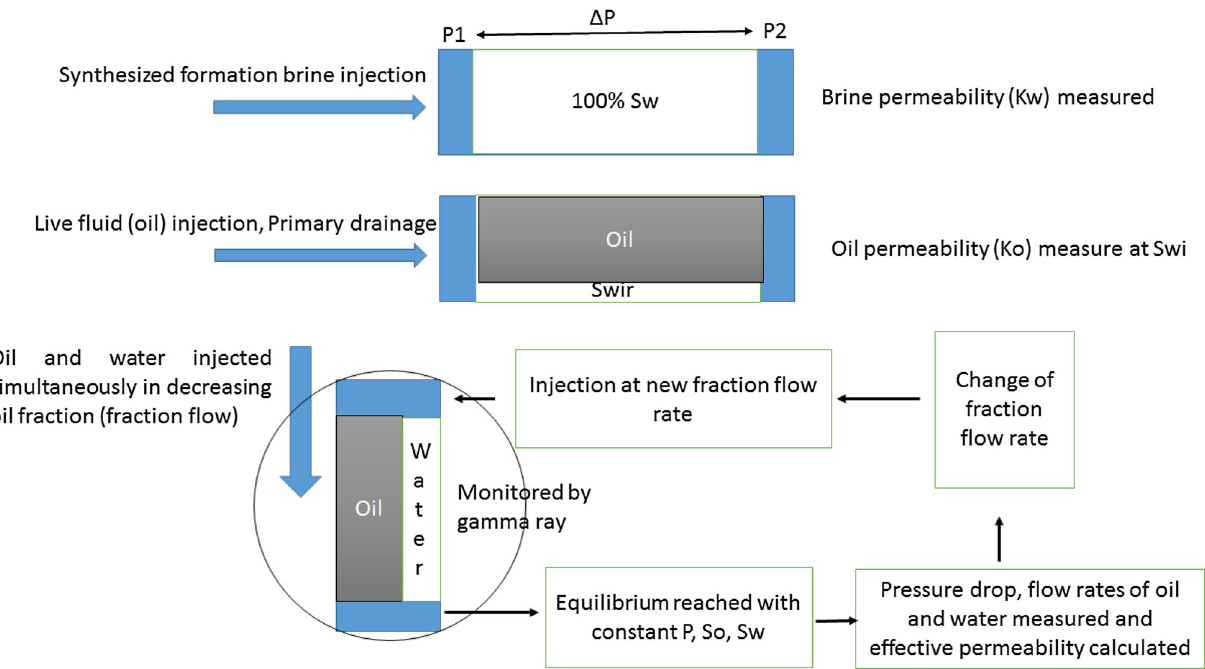
Fig. 9 Schematic diagram of relative permeability measurement procedure by steady state